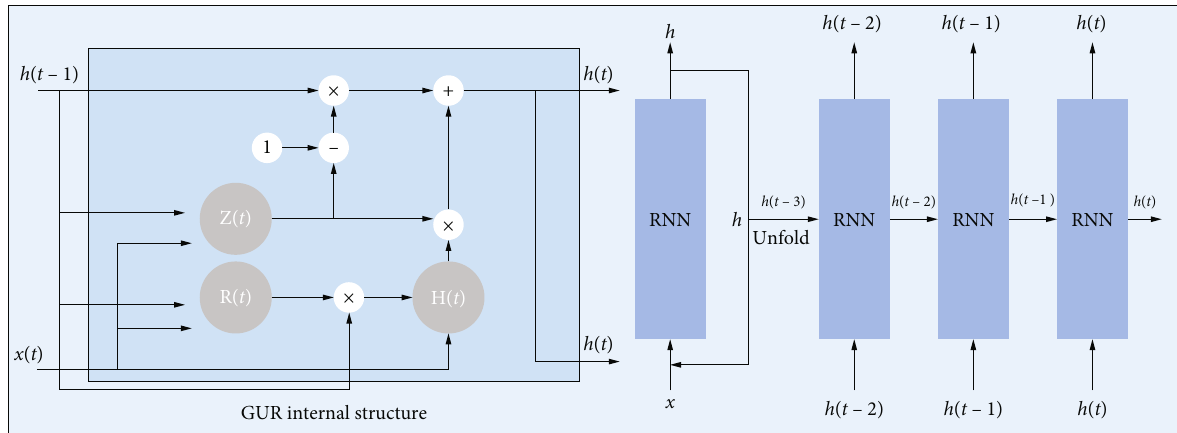
Figure 2: Internal structure and expanded structure diagram of the cyclic element